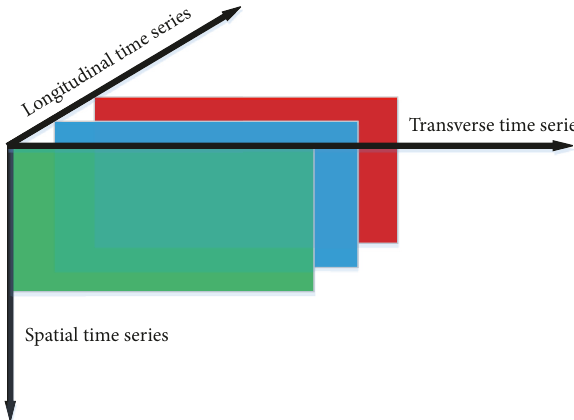
Figure 1: Structure of a third-order tensor model of traffic flow. 𝑞 = 7 . During the rolling prediction of traffic flow, when the cycle length is 𝑞 = 7 , which is the same as the length of the data test in [44, 45], the simulation precision is the